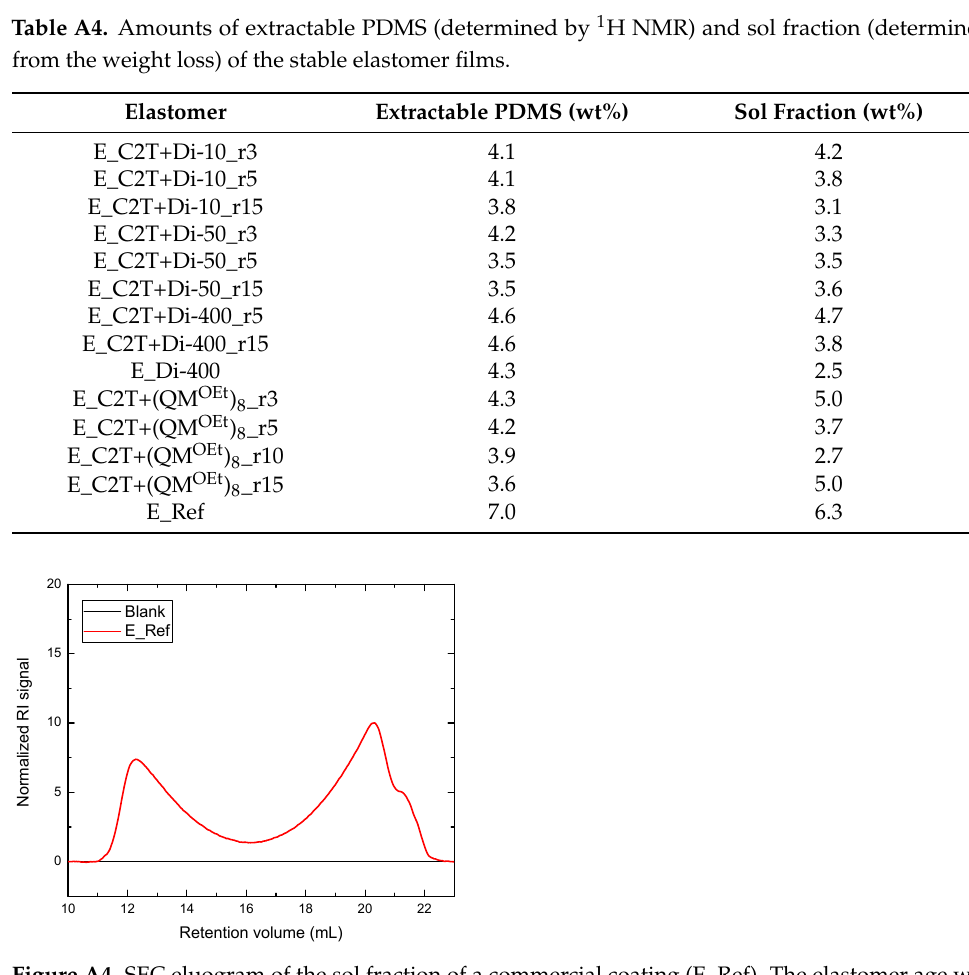
Figure A4. SEC eluogram of the sol fraction of a commercial coating (E_Ref). The elastomer age was 27 days.